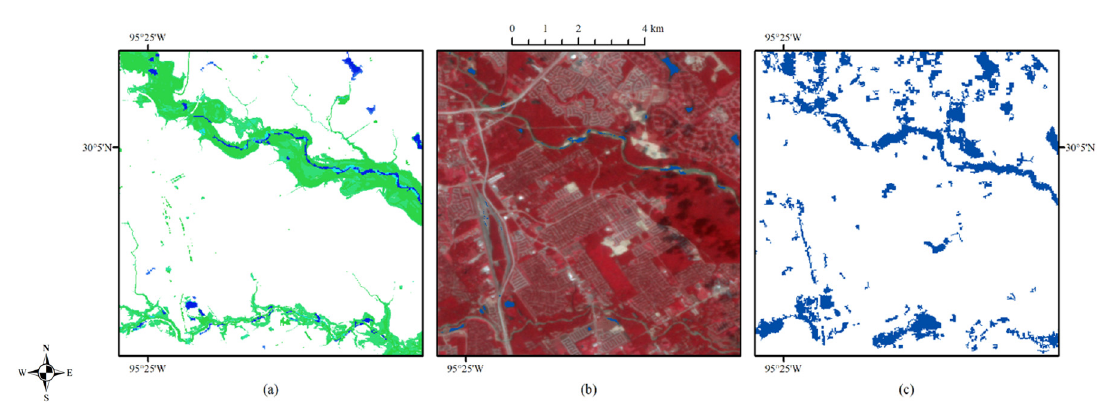
Figure 14. Enlarged site (D): inundation probability ( a ), the corresponding optical image on 1 September ( b ), and ( c ) FEMA flood map, with water shown in blue.